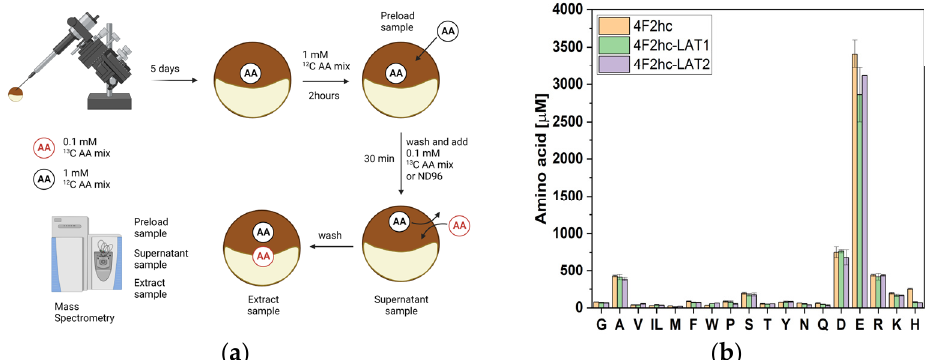
Figure 2. Analysis of Xenopus laevis oocyte amino acid pools. ( a ) After expression for five days oocytes were incubated with 12 C (black) and 13 C amino acids (red) in the order shown. Three samples were analysed for each experiment, namely the preload sample, supernatant sample and extract sample. ( b ) Cytosolic amino acid concentrations after incubation in a 1 mM 12 C amino acid mix of oocytes expressing 4F2hc, 4F2hc + LAT1 or 4F2hc + LAT2 (Preload sample). Isoleucine and leucine cannot be separated by LC–MS and their sum is shown as